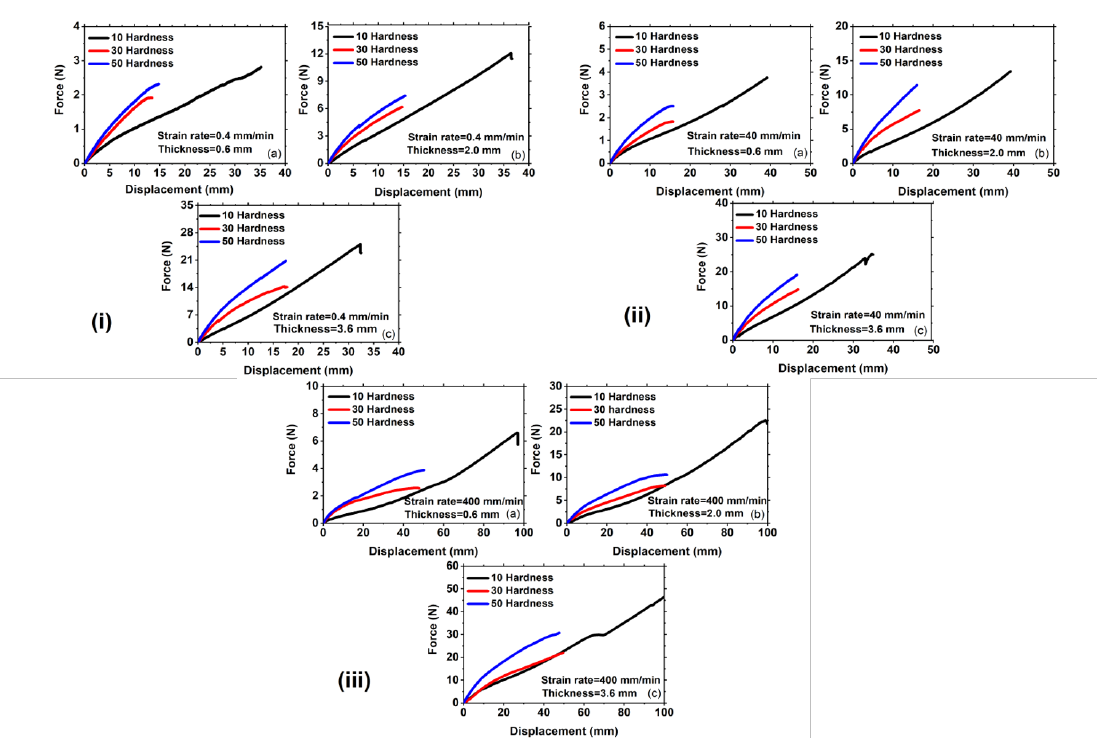
Figure 6. Representation of force versus displacement curves of the specimen under pure shear loading at strain rates of ( i ) 0.4 mm/min for different thicknesses of ( a ) 0.6 mm; ( b ) 2 mm; and ( c ) 3.6 mm, respectively, ( ii ) 40 mm/min for different thicknesses of ( a ) 0.6 mm; ( b ) 2 mm; and ( c ) 3.6 mm, respectively, ( iii ) 400 mm/min for different thicknesses of ( a ) 0.6 mm; ( b ) 2 mm; and ( c ) 3.6 mm, respectively. Note: the scales of the figures are